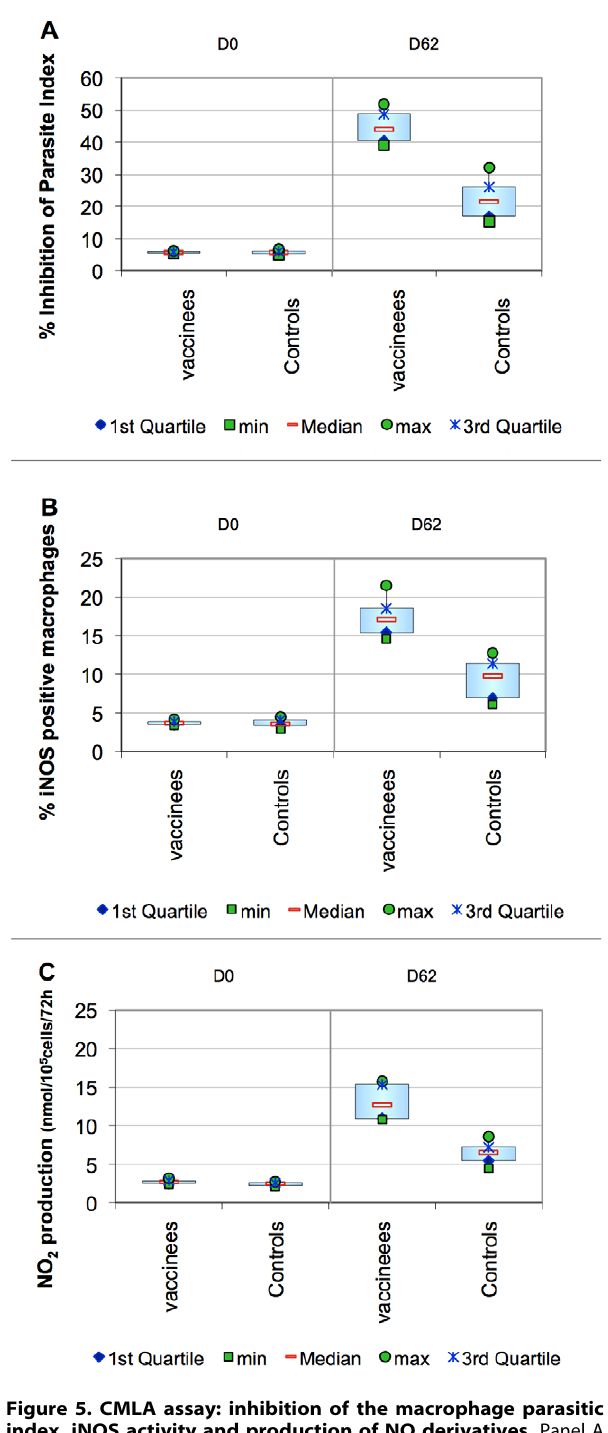
Figure 5. CMLA assay: inhibition of the macrophage parasitic index, iNOS activity and production of NO derivatives. Panel A is a comparison of the ability of the macrophages to inhibit parasite multiplication before vaccination (D0) and 3 weeks after completion of the primary course (D62). It demonstrates the increase in the inhibition of the macrophage parasite index as a result of vaccination. Panel B Is a comparison of the rate of expression of iNOS in the macrophages before vaccination (D0) and 3 weeks after completion of the primary course (D62). Panel C is a comparison of the rate of production of NO derivatives from the macrophages to before vaccination (D0) and 3 weeks after completion of the primary course (D62). When these three measurements are consistent, this provides evidence of an increased NO-mediated pathway of parasite killing as a result of vaccination.